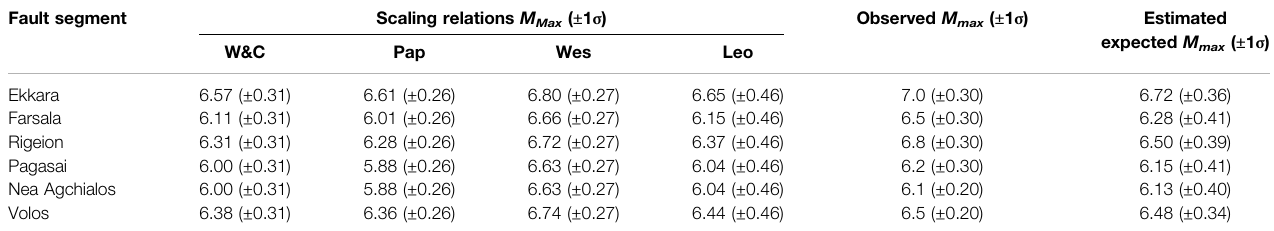
TABLE 3 | Estimated M max and its ± 1 σ as obtained from the Wells and Coppersmith (1994; W&C), Papazachos et al. (2004; Pap), Wesnouskly (2008; Wes), and Leonard (2010; Leo) scaling relations for each of the six segments of the Southern Thessaly Fault Zone, along with the observed M max values (also listed in Table 1 ) used for the fi nal estimation of the M fi nal estimates and their corresponding error (last column) using the modi fi ed version of Pace et al. (2016) method are also given. max . The